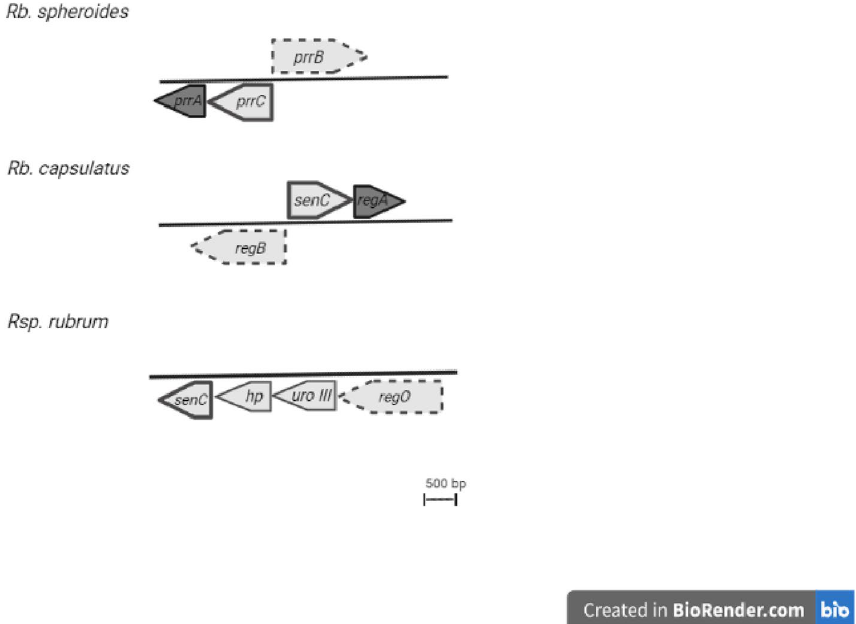
Fig. 1 Physical and genetic maps of the photosynthetic regulatory gene cluster in different Rhodobacter species compared to Rhodosprillum . ORFs and their directions of transcription are represented by open arrows. Rba., Rhodobacter capsulatus; Rba., Rhodobacter sphaeroides . (drawn by Biorender). Gene organization in the regO gene locus of Rhodosprillum rubrum ( Rsp. rubrum ); hp, hypothetical protein; uroIII, predicted uroporphyrinogenIII